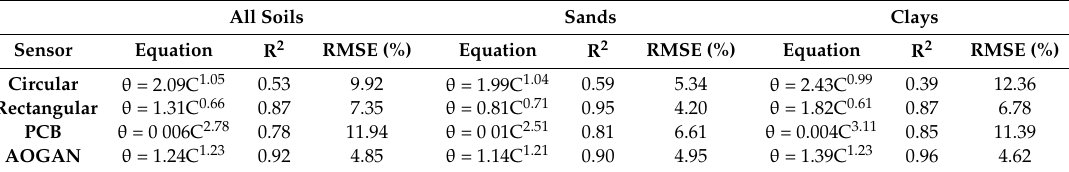
Figure 9. Combined capacitance, C and dielectric constant, κ ’, data versus volumetric water content, θ , for the: ( a ) Circular, ( b ) Rectangular, ( c ) PCB and ( d ) AOGAN sensors. Highlighted yellow markers capture the capacitive data for all soils and different markers represent different soil samples. Separate calibrations are used for describing the sand group (black solid trendline) and clay group (blue dashed trendline). Table 11. Performance of the sensors against combined soil, combined sand group and combined clay group